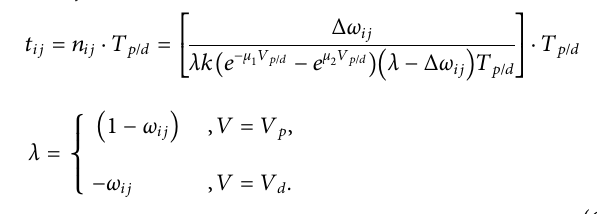
TABLE 1 | List of the parameters used in the memristor model.